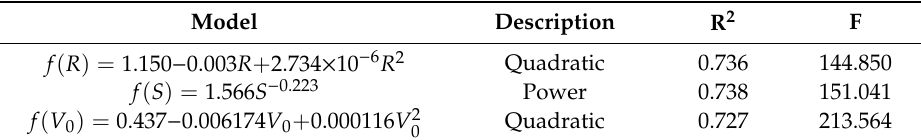
Table 11. Unary regression models.